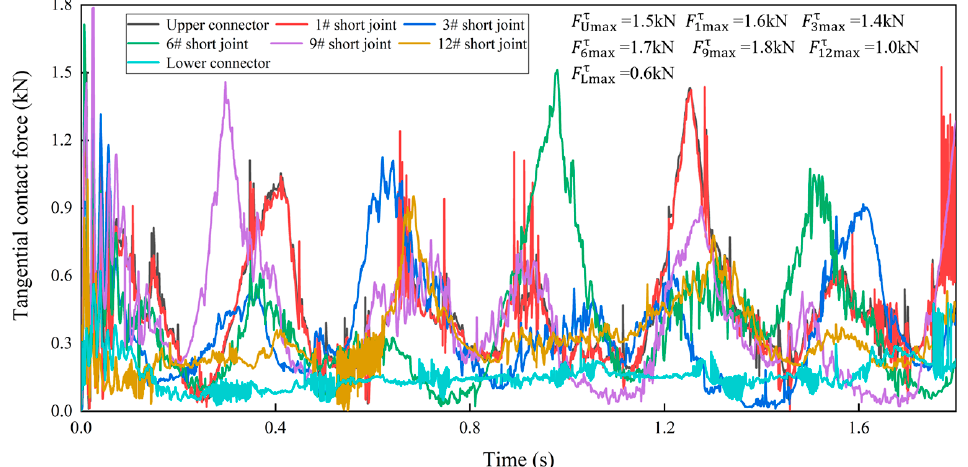
Figure 13. Tangential contact force between upper and lower connectors and ball key, and 1#, 3#, 6#, 9#, 12# flexible drill pipe and ball key.